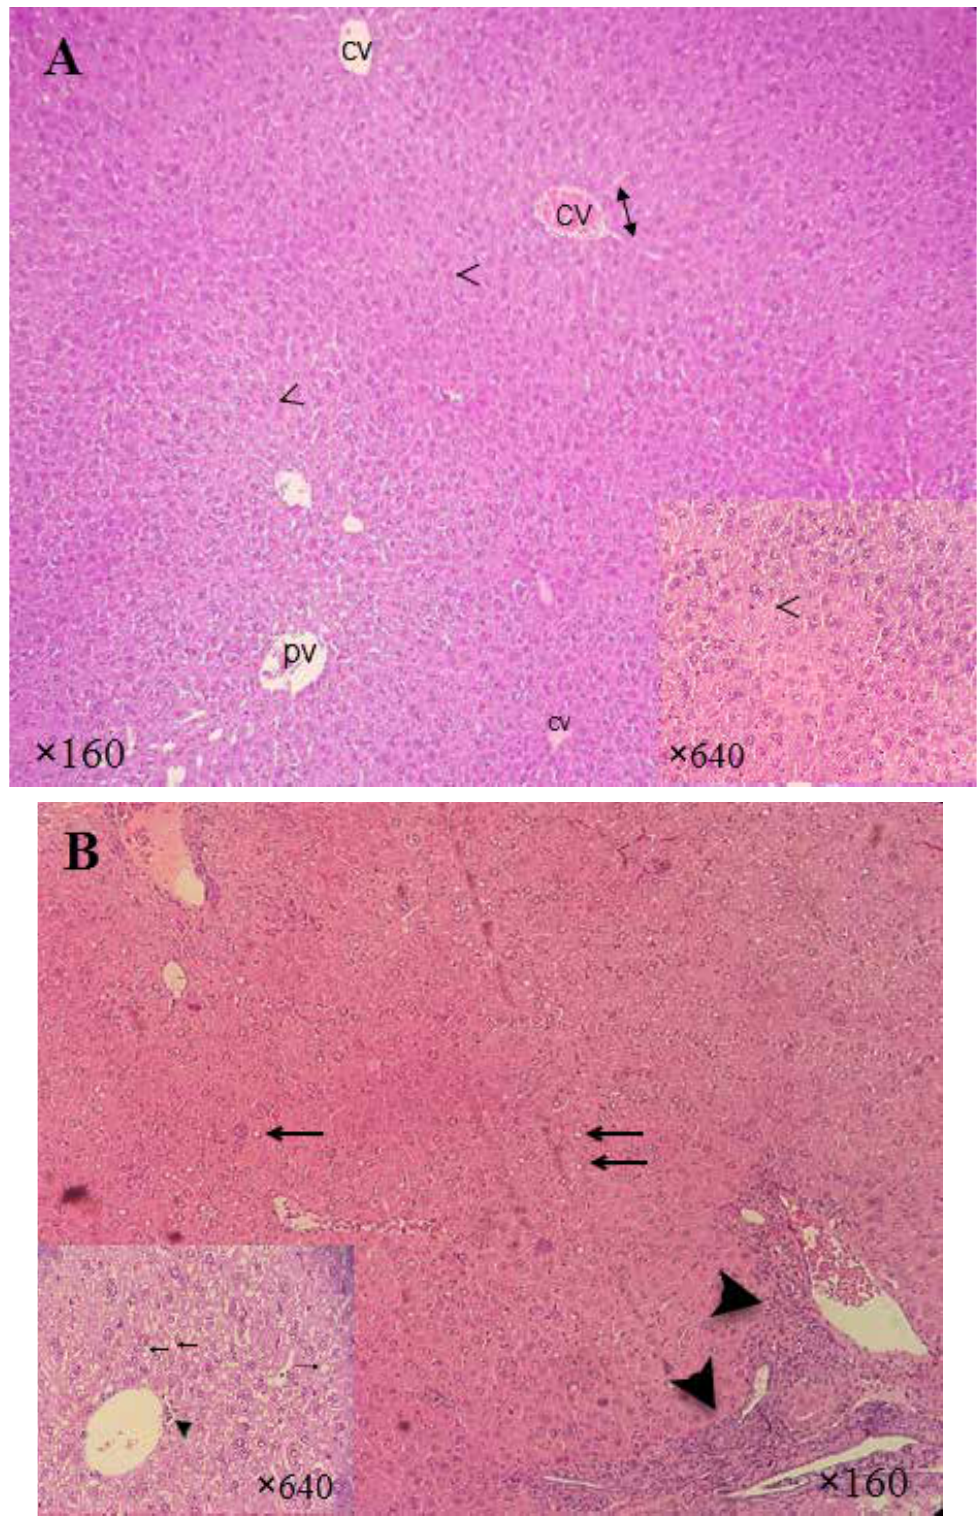
FIGURE 3 – H&E-stained sections of liver from the following groups: control (A), negative control (fatty liver + solvent) (B), and positive control (fatty liver + silymarin) (C), group I (fatty liver + 6-gingerol 400 mg/kg) (D), group II (fatty liver + 6-gingerol 800 mg/kg) (E). Abbreviatio ns: CV: central vein; PV: portal vein. Symptoms: lipid droplets sediment (one-pointed arrow); accumulation of inflammatory cells (thick arrow tip); sinusoidal spaces (two-pointed arrow), hepatocytes (thin arrow